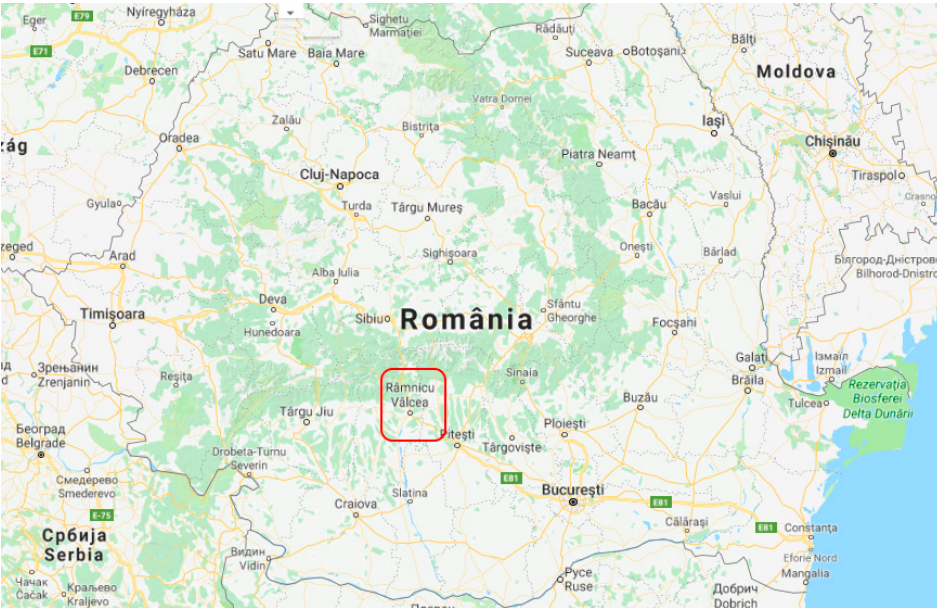
Figure 2. Location of Ramnicu Valcea city in Romania (the red square in the figure).